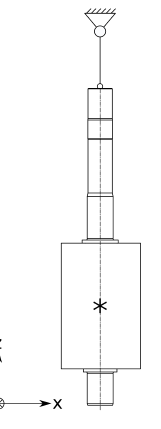
Figure 8. Schematic representation of the measurment setup, the asterisk ∗ marks the measur- ing